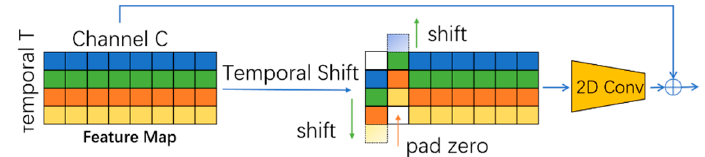
Figure 3. The structure of a temporal shift (TS) module.